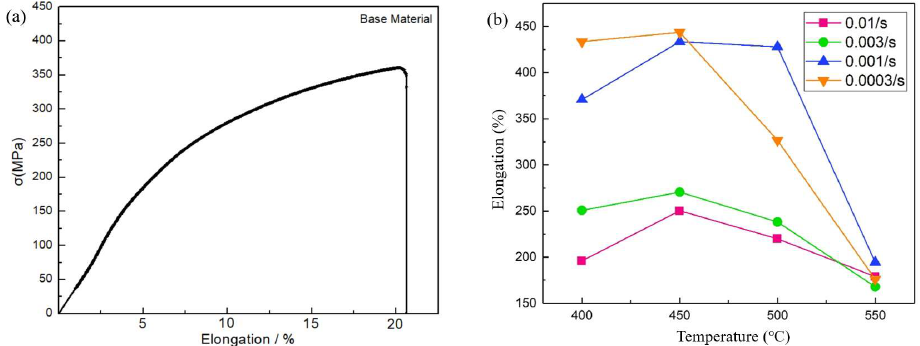
Figure 7. Mechanical performance of FSW AZ31 magnesium alloy deformation at different temperatures and strain rates: ( a ) stress-strain curves at room temperature; ( b ) elongation with high temperature.